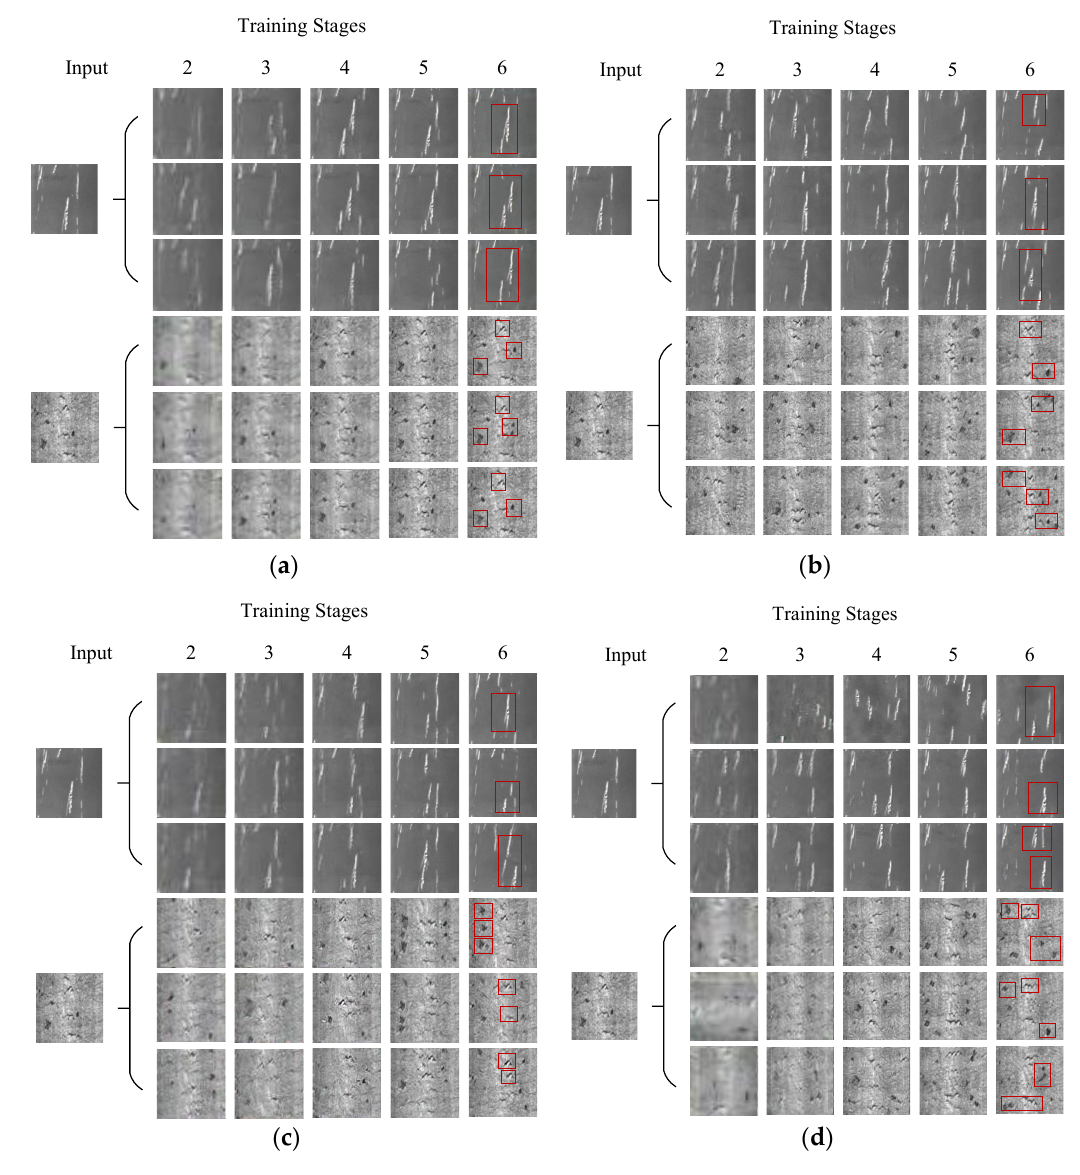
Figure 14. Ablation contrast experiment result. ( a ) ConSinGAN training results. ( b ) Training results after changing the means of image size change. ( c ) Training results after changing the iteration times. ( d ) Increased training results after ECA-Net.